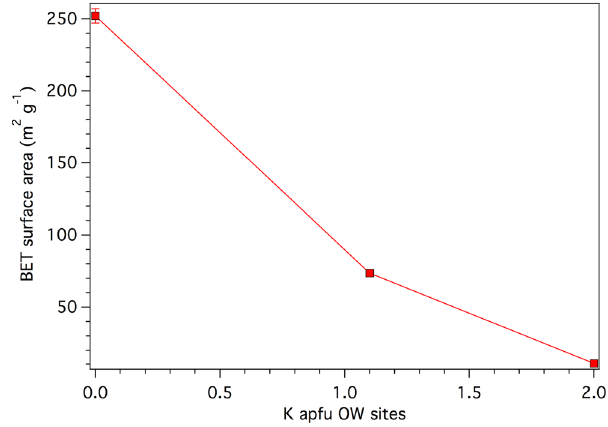
Figure 2. BET surface area as a function of the K content in the OW